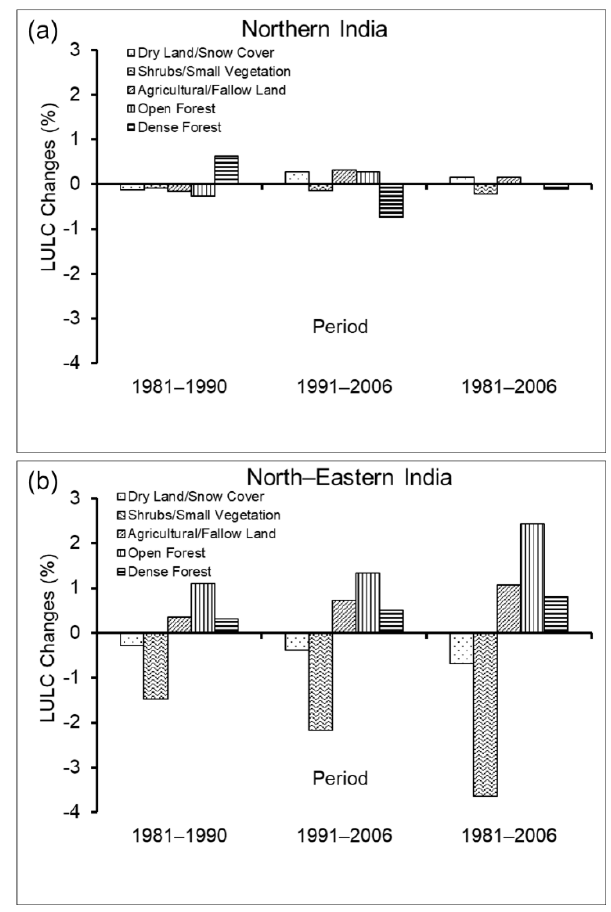
Figure 6. LULC changes over ( a ) NI and ( b ) NEI.